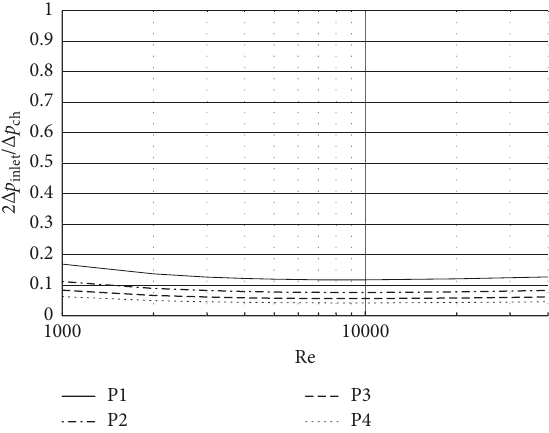
Figure 16: Inlet pressure drop ratio IR HH corrugated field.